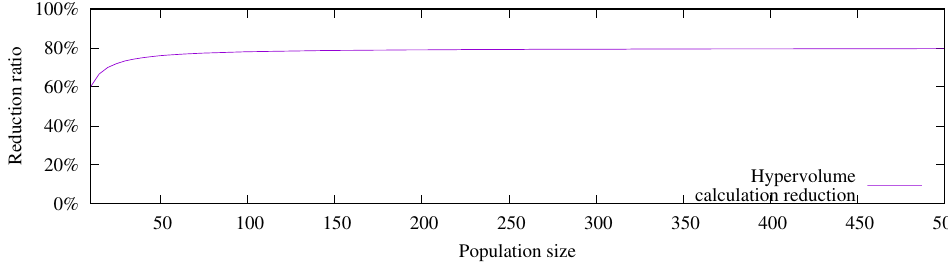
Figure 2. Reduction of H c computations in LIBEA-II adopting ρ c = 0.1 and ρ n =